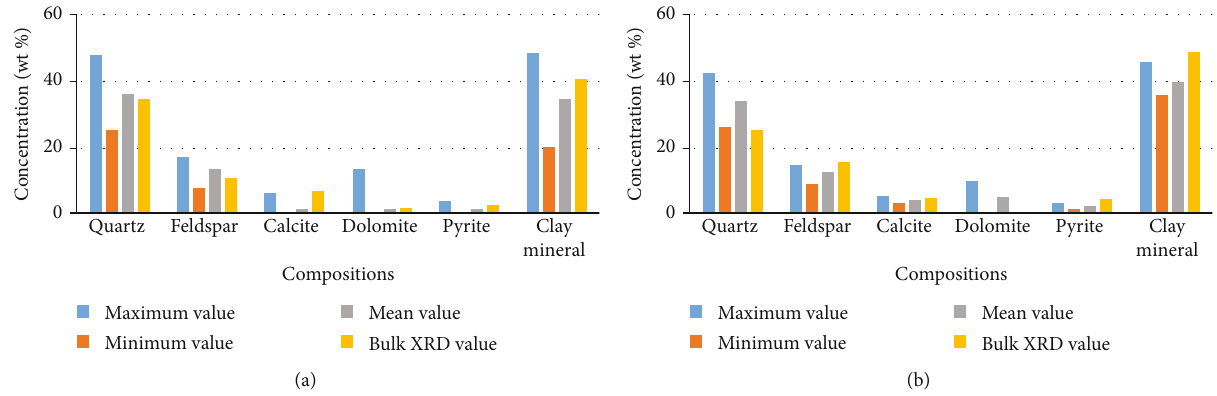
Figure 6: Histograms showing the maximum, minimum, and mean values of (a) silty laminated sample L-1 and (b) massive argillaceous shale L-2. The mean value determined from micro-FTIR-predicted values are compared with the XRD-measured bulk sample